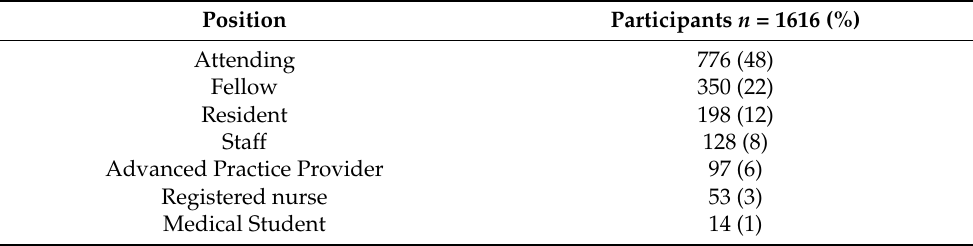
Table 2. Self-reported position of participants in the Pediatric Neurocritical Care Education Series.